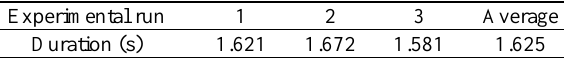
Table 2. Durations of processing